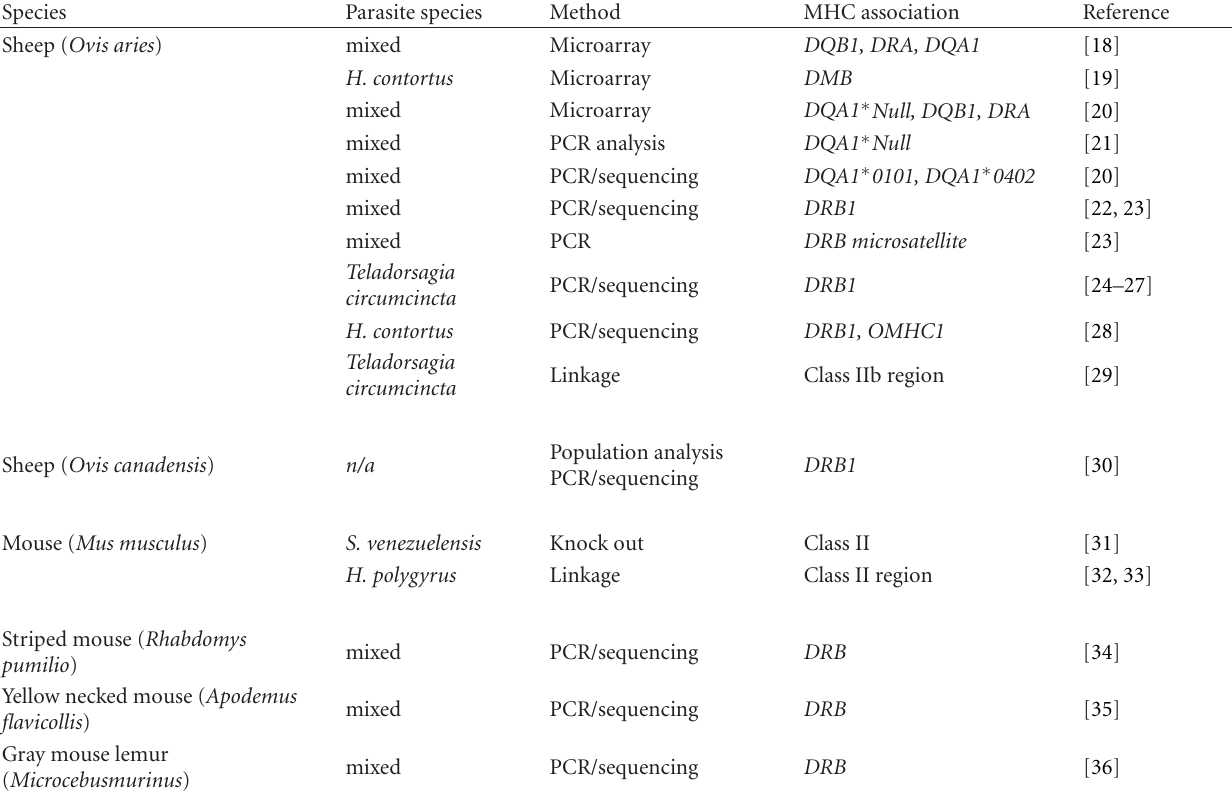
Table 1: Summary of studies that have implicated the MHC in resistance to gastointestinal parasites.